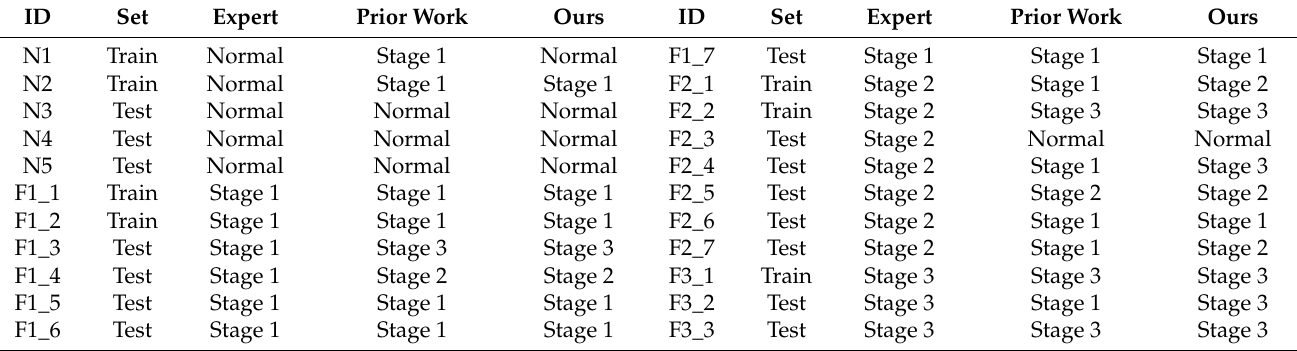
Table 9. Comparison of the proposed fluorosis classification approach with that of Yeesarapat et al. [14] on 7 training images and 15 blind test images.